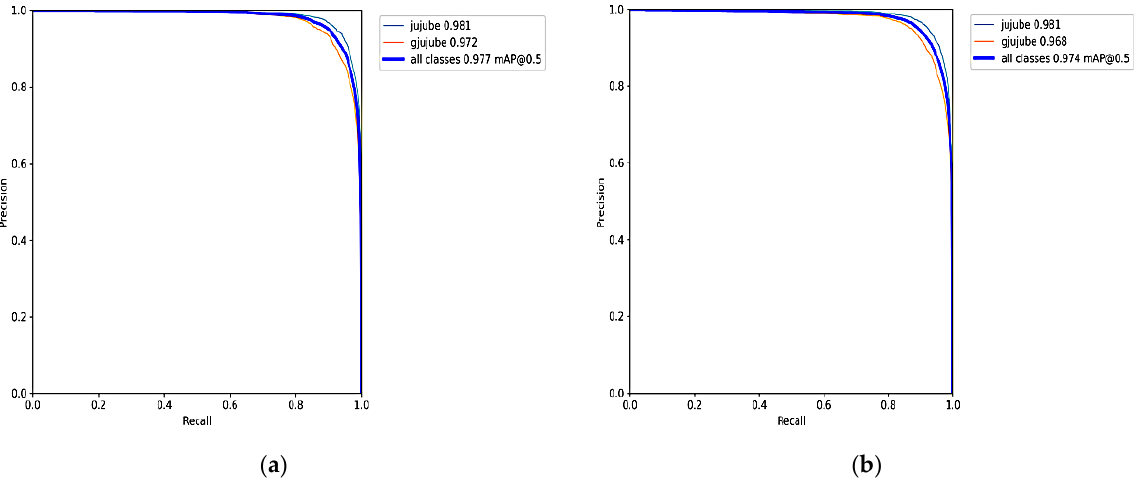
Figure 9. PR_curve of the YOLOv5s-CE and YOLOv5-GCE ( a ) Improved network; ( b ) Lightweight Improved network.